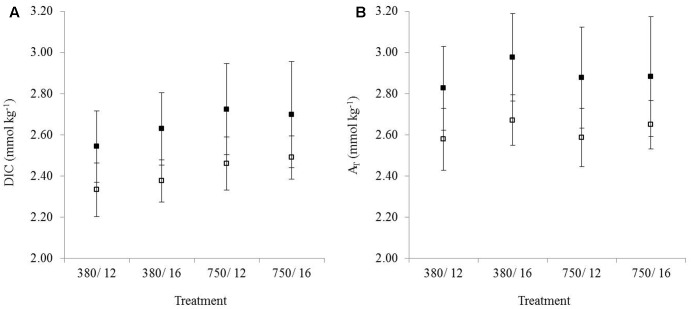
The mean (n = 3) concentration of (A) DIC (dissolved inorganic carbon) and (B) AT (total alkalinity) from the control and treatment flumes. Error bars represent the standard deviation. Samples were taken from the overlying water in the daytime for muddy sediment (solid black squares) and sandy sediment (white squares). Treatments on the x-axis represent environmental conditions during the experiment.